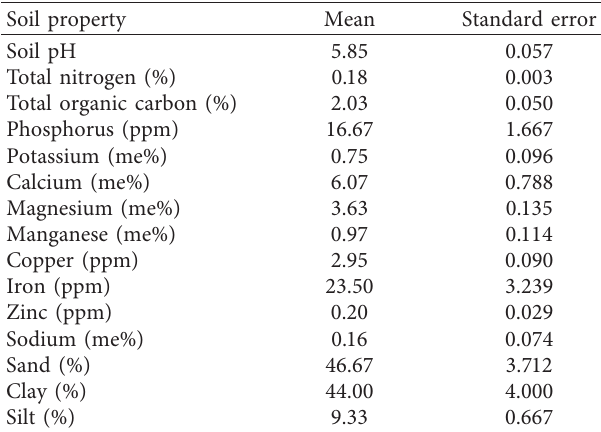
Table 2: Soil physicochemical characteristics at Nyangati study site in Mwea subcounty,